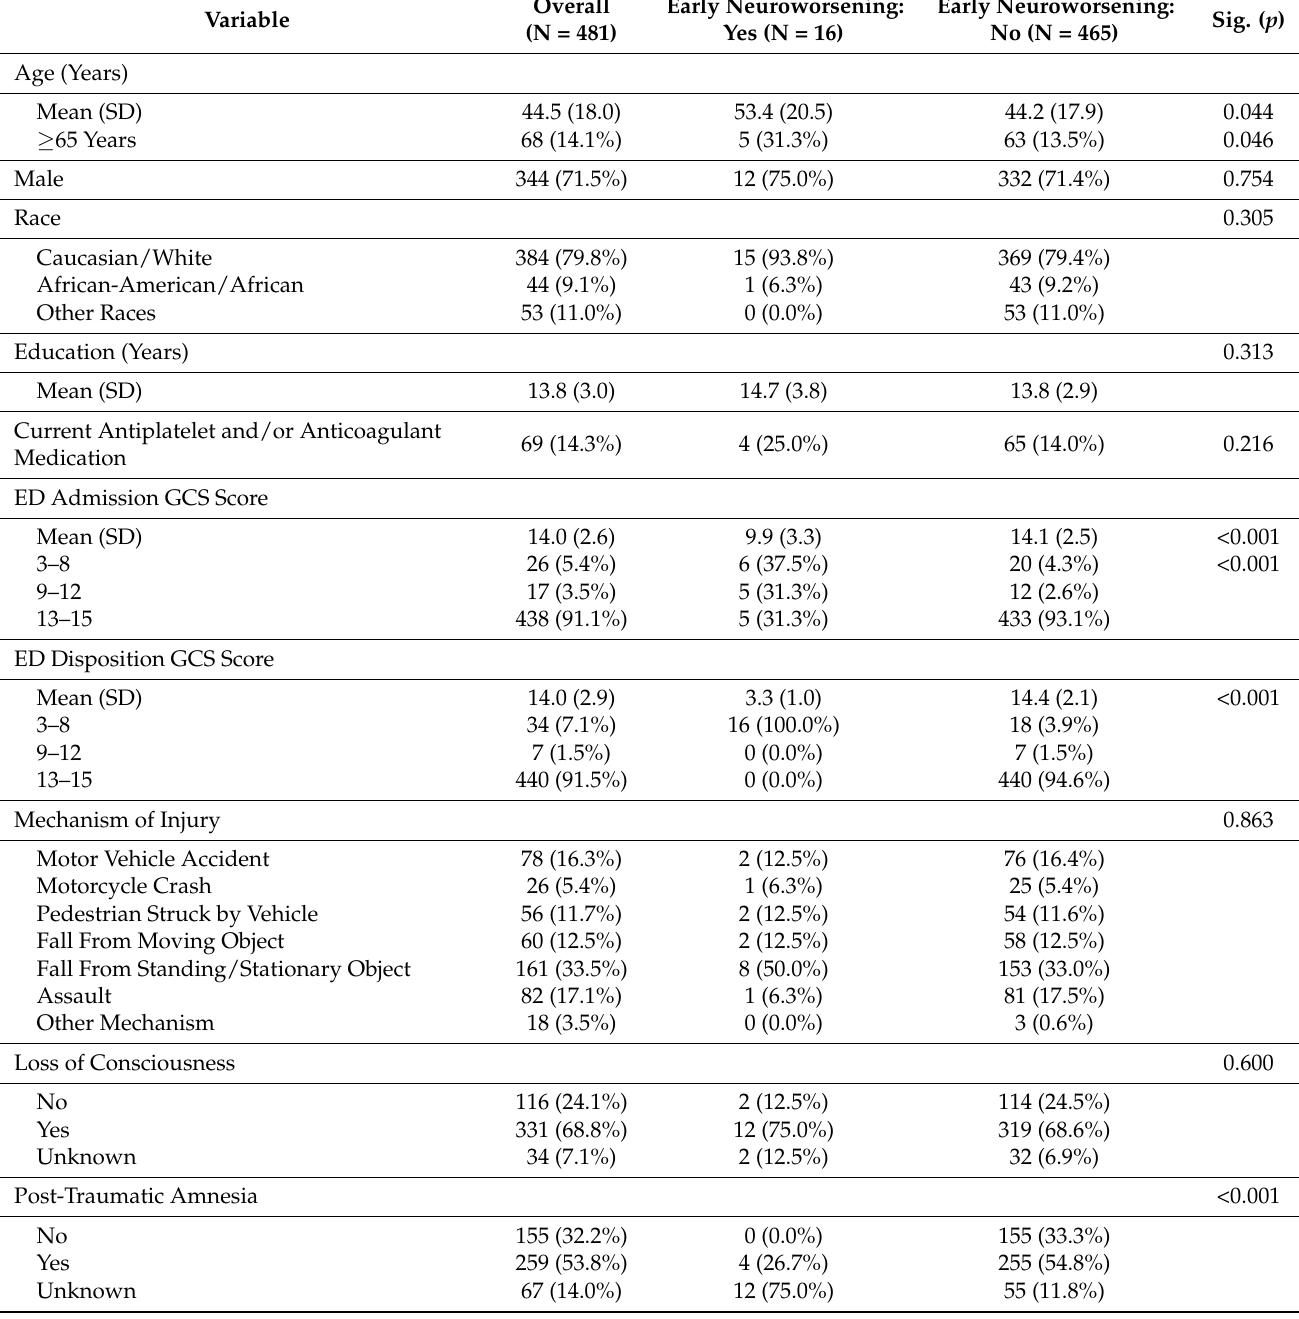
Table 1. Demographic and presentation characteristics by early neuroworsening. Demographic, clinical, and injury variables compared by early neuroworsening status. Only a subset of subjects had recorded data for ED blood alcohol screen (group sizes (N) are shown). ED hyperosmolar